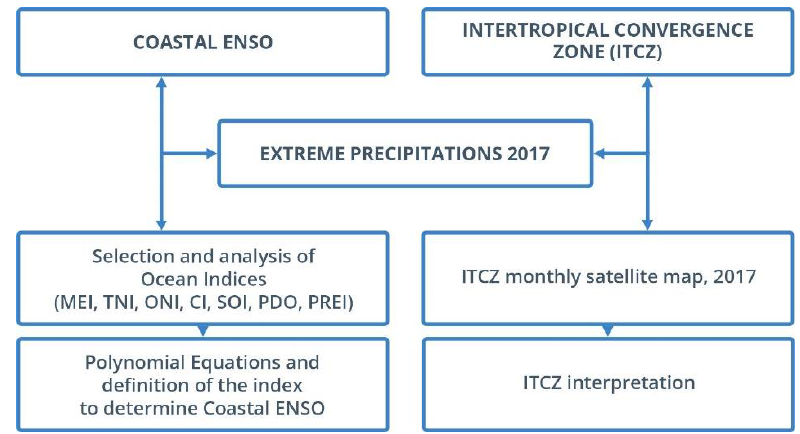
Figure 2. Diagram of the methodological process.